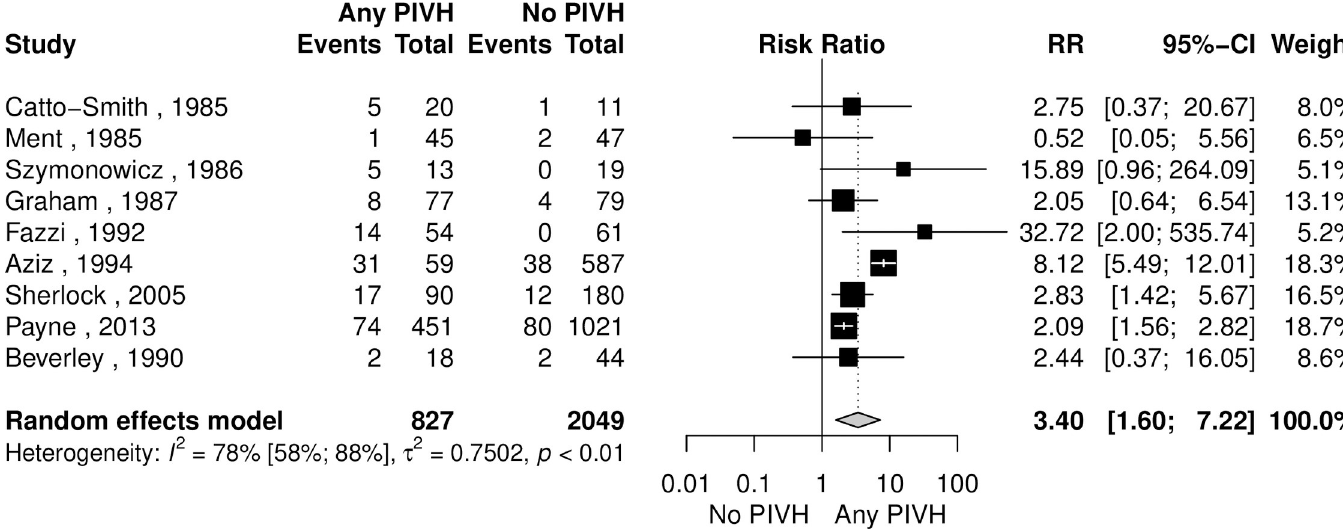
Fig 4. Risk ratio of cerebral palsy comparing children with any peri-intraventricular haemorrhage (PIVH) and those without PIVH.